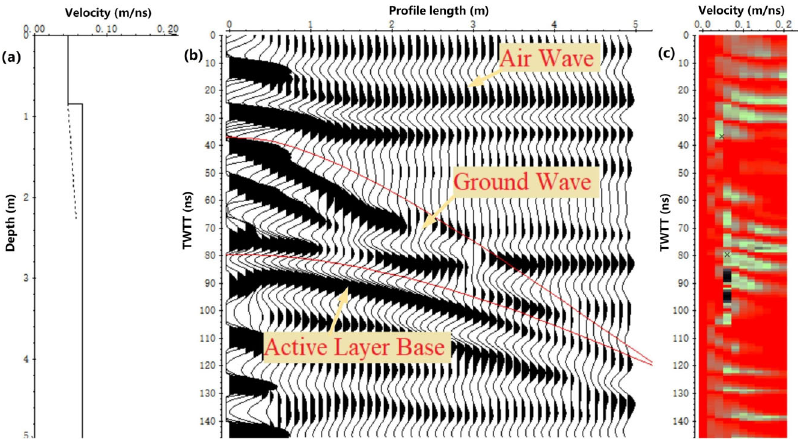
Figure 3. Flow chart of ground ‐ penetrating radar (GPR) data processing performed to derive the active layer thickness (ALT). CMP: common midpoint.